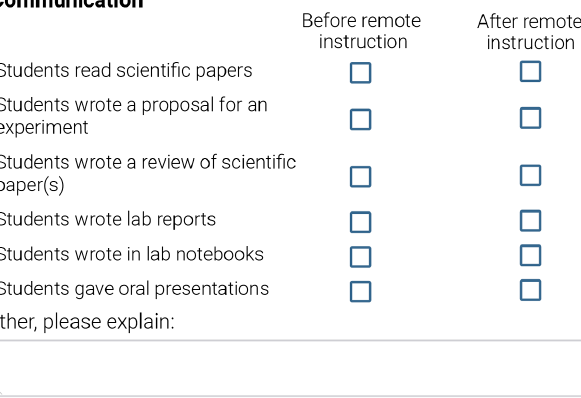
FIG. 1. An example question from the instructor survey, where instructors could check boxes to indicate the activities that happened in their courses before and/or after the transition to remote